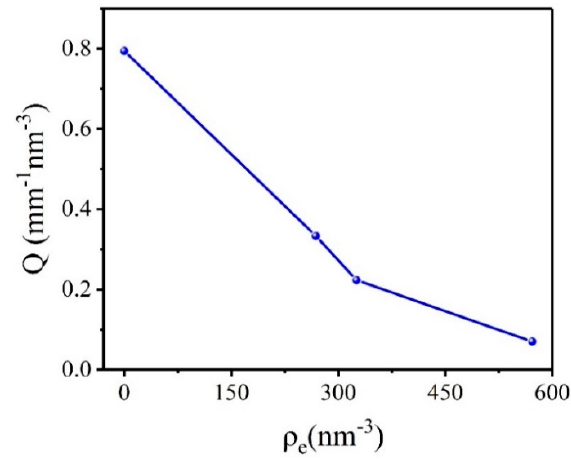
Figure 1. Scattering invariant Q of HMX crystal in different electron density matching solutions.